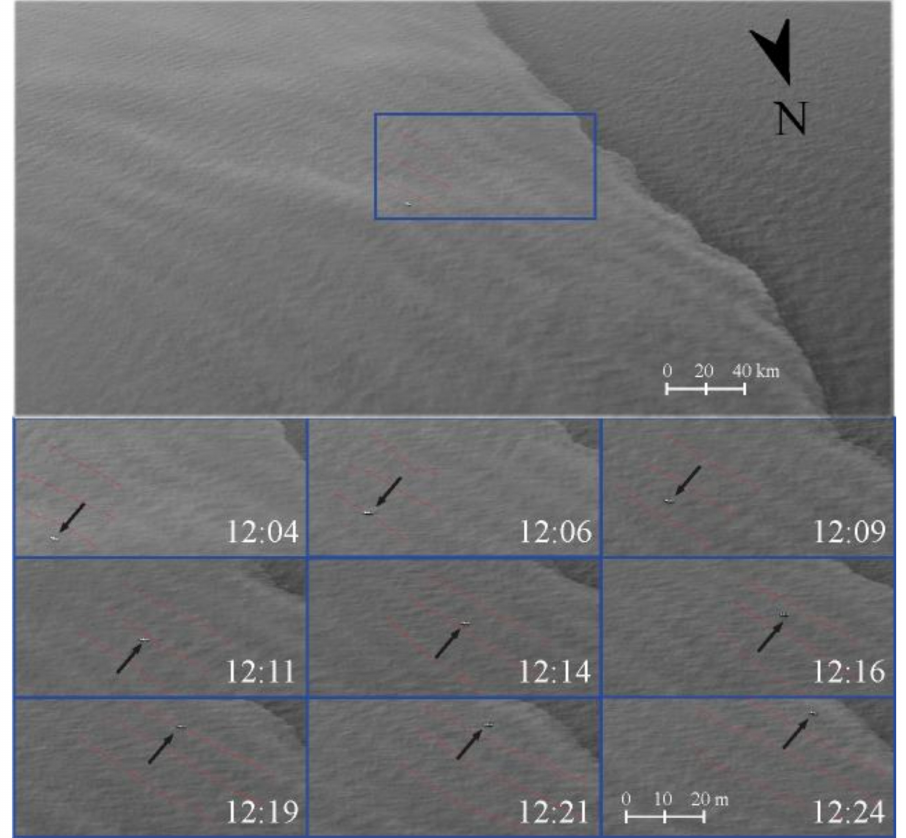
Figure 6. Processed aerial images of the Byzb plume on 18 April at 12:04–12:25 during the third drifting boat experiment. Top image shows the far-field part of the Bzyb plume; bottom images show the zoomed-in area (indicated by the blue square in the top image). Red lines indicate ring-like features; black arrows indicate location of the free-drifting boat. Note that the frame of the bottom images is not moving.